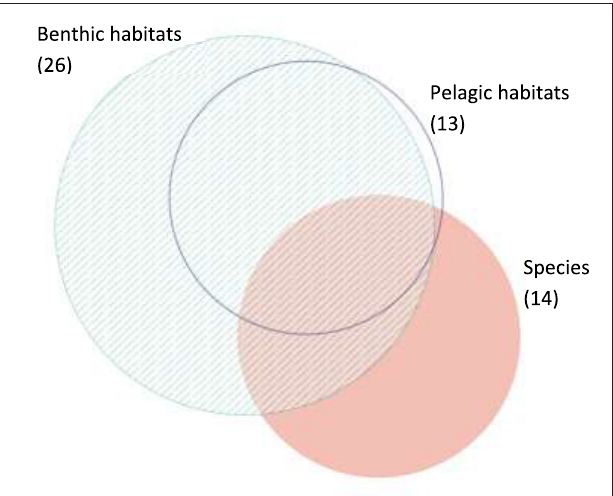
FIGURE 3 | Venn diagram for the inclusion of ecosystem components (species/species groups, benthic habitats, and pelagic habitats) in the reviewed CPIAs. Note that the number of studies in the figure is > 40, because a CPIA can assess all the categories. Source of the Venn diagram: EulerAPE